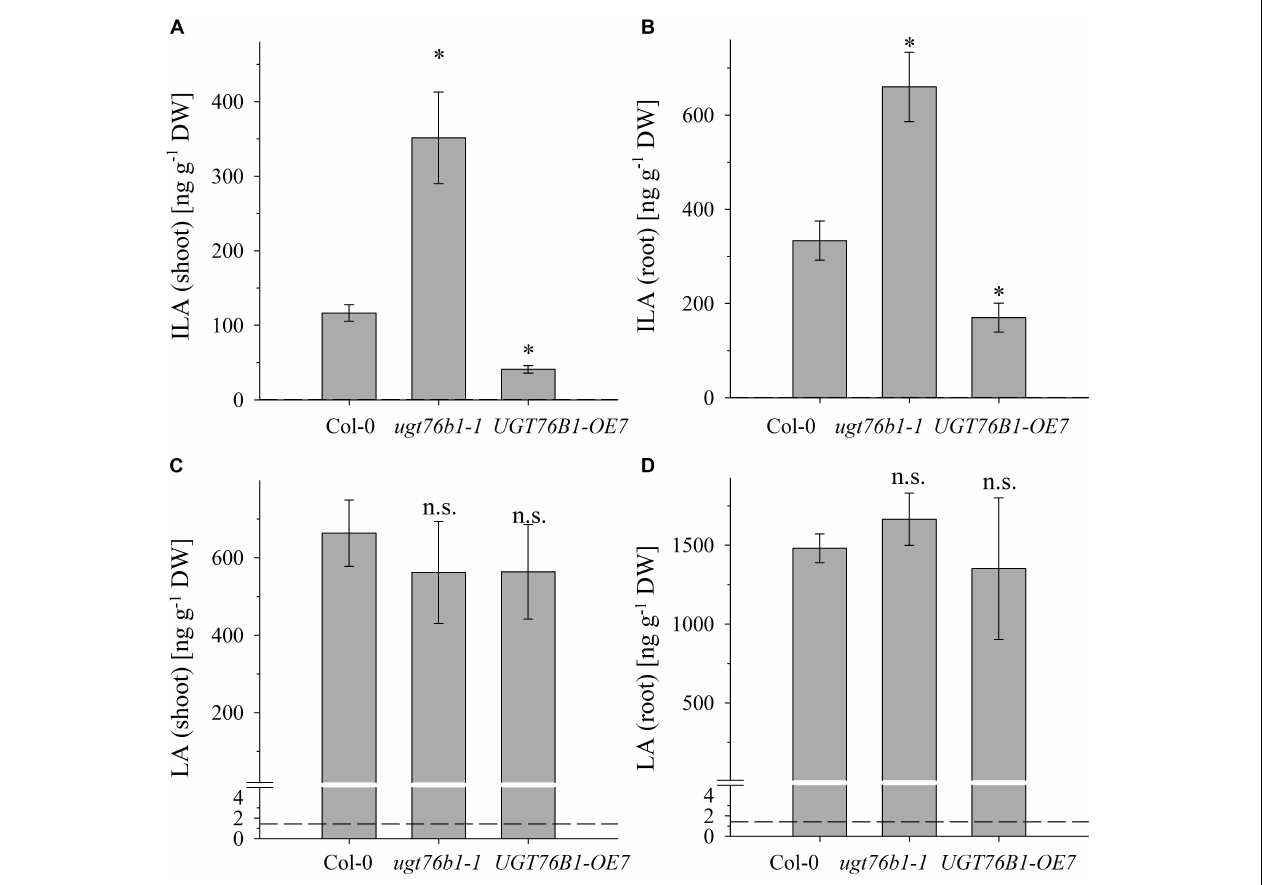
FIGURE 3 | The abundance of ILA and LA in above- and below-ground tissues of Col-0, ugt76b1-1 and UGT76B1-OE7. Levels of (A,B) ILA and (C,D) LA in (A,C) shoot and in (B,D) root in 3-week-old Col-0, ugt76b1-1 and UGT76B1-OE7 plants grown on Gelrite plates in short-day conditions (10 h photoperiod). Means ± SE ( n = 4) are plotted. Asterisks indicate statistically significant differences in comparison to wild type (Col-0) ( ANOVA ), ∗ p -value < 0.05. Dashed lines indicate the limit of detection (see section “Materials and Methods”).